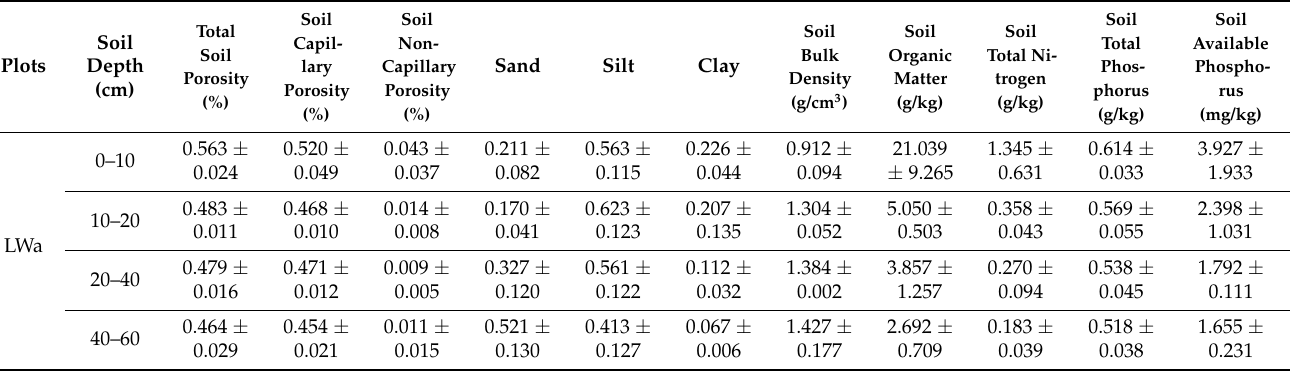
Figure 1. Location of the study area. Table 1. Soil properties at each soil depth at LWa and